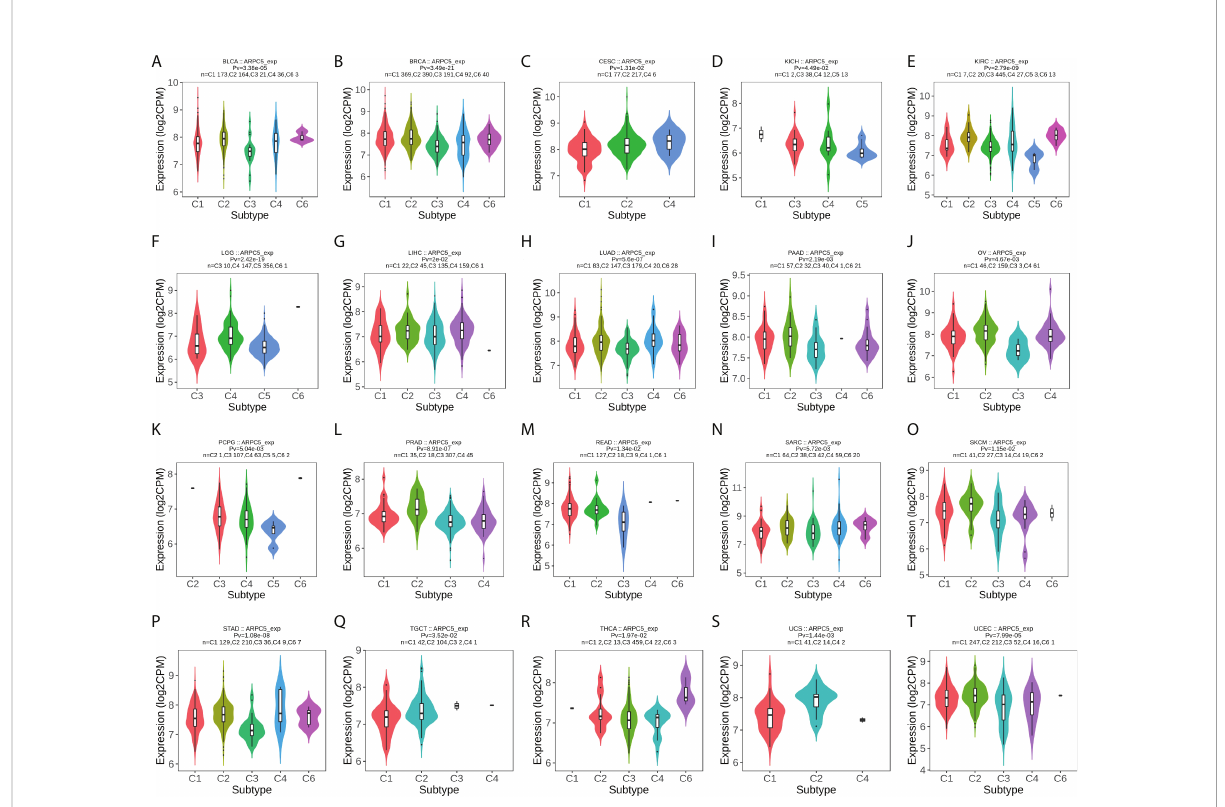
FIGURE 7 The correlation between ARPC5 expression and immune subtypes in pan-cancer using TISIDB. The cancers with signi fi cant correlation were displayed. (A) In BLCA. (B) In BRCA. (C) In CESC. (D) In KICH. (E) In KIRC. (F) In LGG. (G) In LIHC. (H) In LUAD. (I) In PAAD. (J) In OV. (K) PCPG. (L) PRAD. (M) In READ. ( N) In SARC. (O) In SKCM. (P) In STAD. (Q) In TGCT. (R) In THCA. (S) In UCS. (T) In UCEC. Pv; p -value. C1, wound healing; C2, IFN-gamma dominant; C3, in fl ammatory; C4, lymphocyte depleted; C5, immunologically quiet; C6, TGF-b